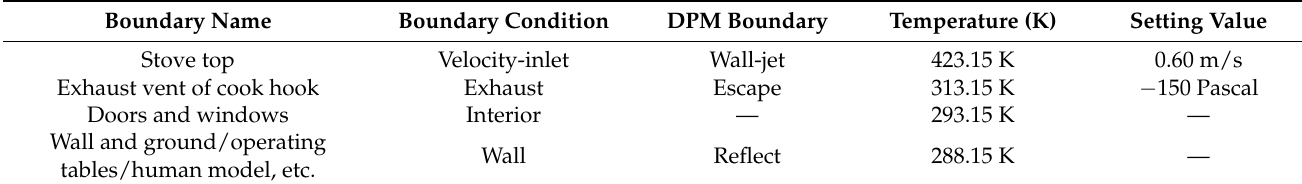
Table 4. Boundary condition settings of